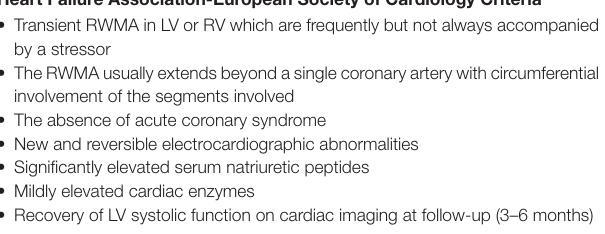
TABLE 1 | The table below summarizes the diagnostic criteria for stress cardiomyopathy. Heart Failure Association-European Society of Cardiology